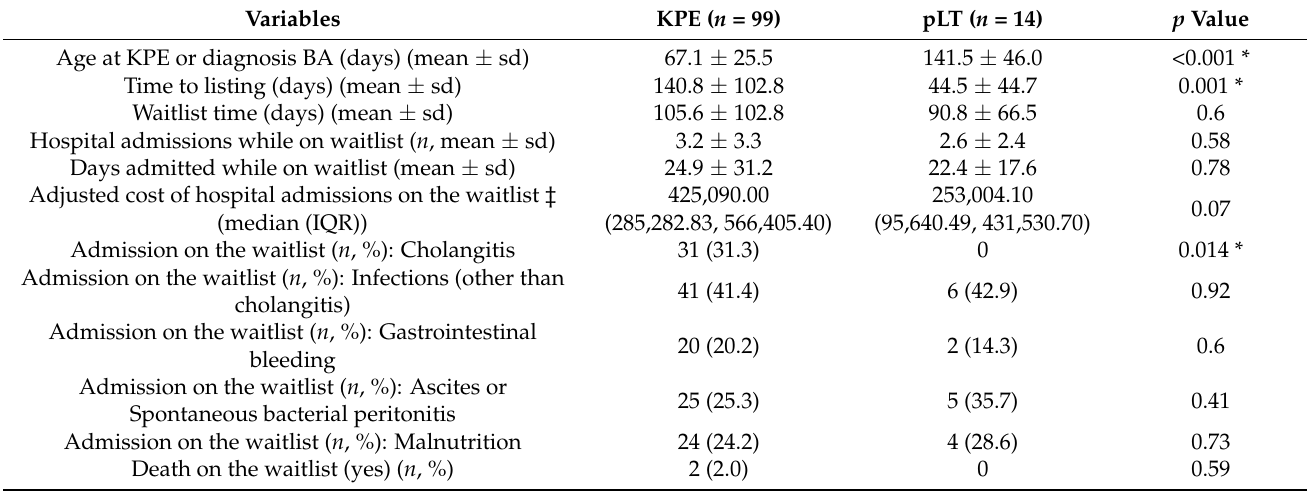
Table 1. Pre-transplant comparison of patients transplanted after KPE or as pLT: (*) represents a statistically significant result; (‡) the pre-transplant admission cost comparison only included patients managed since 2009 who received their KPE at our institution (n = 31) and patients from the pLT group ( n = 10).